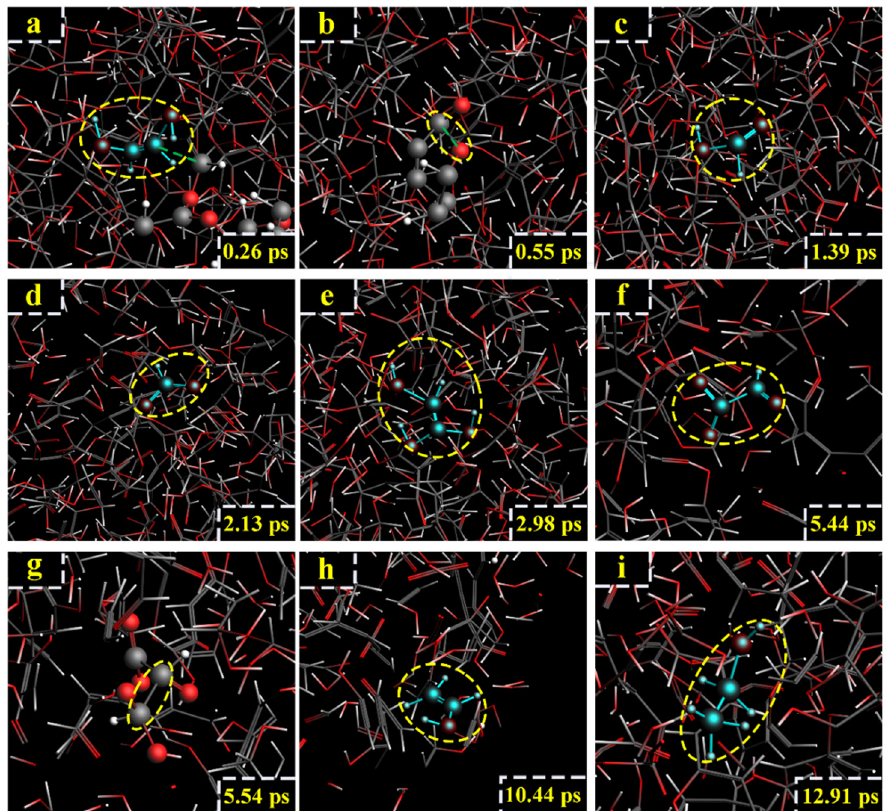
Figure 15. Path III for the production of ethanol. ( a – i ) are the procedure of cellobiose to produce ethanol at 3000 K.